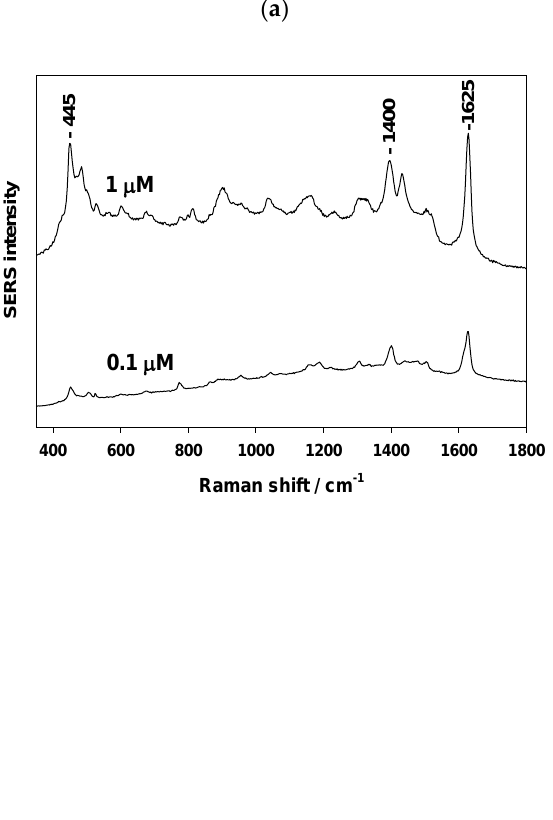
Figure 6. SERS spectra of 5,10,15,20-tetrakis (1-methyl-4-pyridyl)porphyrin (TMPyP).